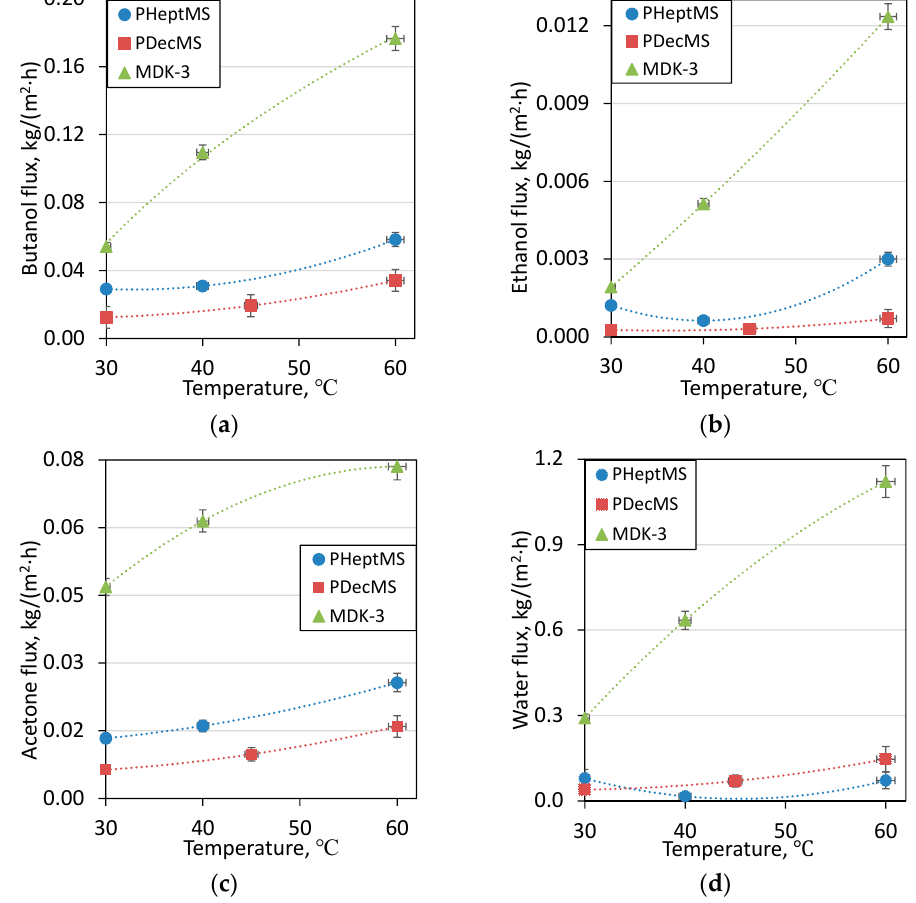
Figure 10. Temperature dependences of permeate flow for butanol ( a ), ethanol ( b ), acetone ( c ), and water ( d ) for PDecMS, PHeptMS, and MDK-3 membranes after contact with the fermentation broth. Table 4. Separation factor ( β ) organic component/water for PHeptMS, PDecMS, and MDK-3 mem- branes at di ff erent temperatures.